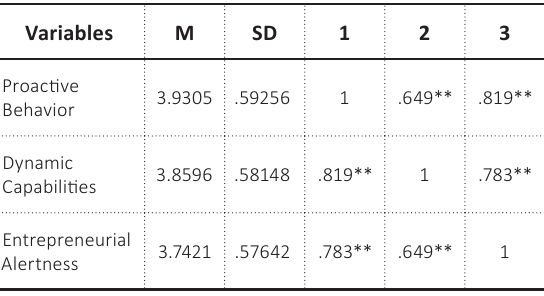
Table 3. Mean, standard